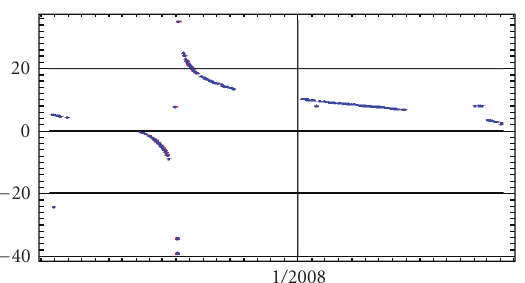
Figure 14: Radial velocities in km/s of Gliese 586A. The time coverage in this plot is ≈ 900 days, that is, one full orbital period of Gl586A. The gaps are the seasons when the target is unobservable. Also note some misidentifications at a constant velocity of 8 km/s (likely one of the other visual binary components, Gliese 586C or D; tbd